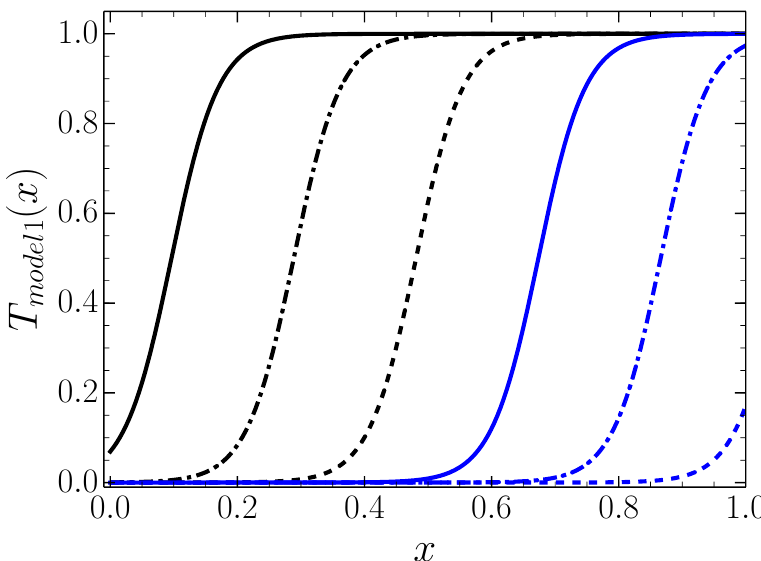
Figure 6. Regge–Wheeler for Schwarzschild: Scalar greybody factors . Toy model # 1, Equation (38), for the greybody factors. From left to right the curves correspond to (cid:96) = 0 to (cid:96) = 5. Note the bad behavior at x = 0, though other gross features of the numerically determined greybody factors are adequately